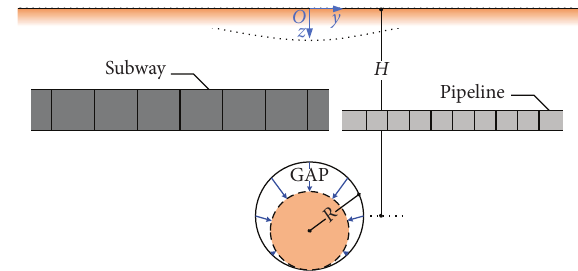
Figure 7: Subway and pipeline.